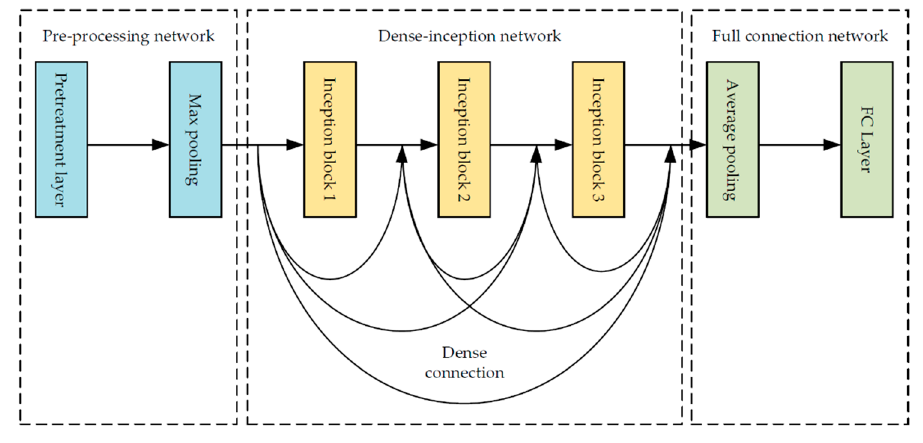
Figure 2. The whole structure of the noise estimation framework.